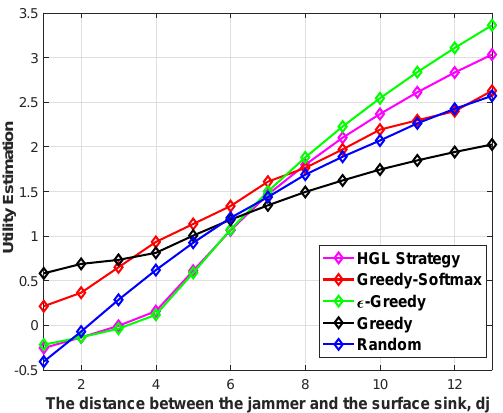
Figure 9. SINR comparison under different